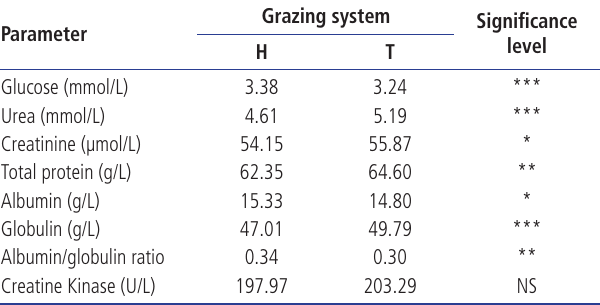
Table 2. Means of blood chemistry parameters of Nguni goats accommodated in earth floors and slatted floors Floor Parameter